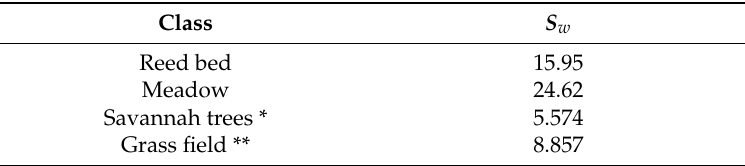
Table 10. Within-class variability (cid:1845) (cid:3050) of reed and meadow classes.